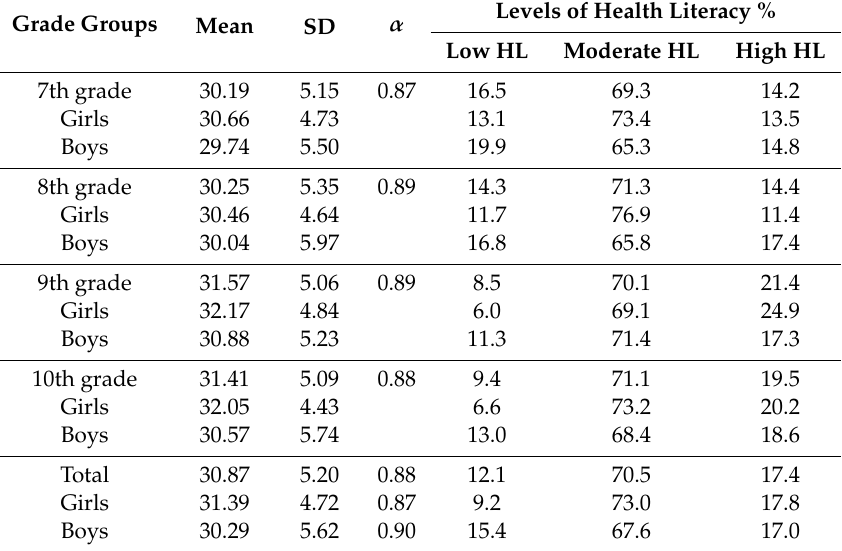
Table 1. Adolescents’ subjective health literacy: comparison by gender and